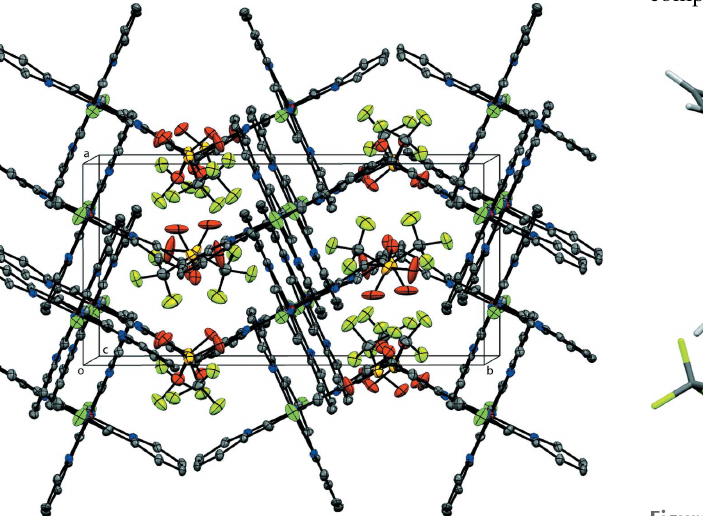
Figure 3 Capped stick representation of the title molecule showing the (cid:2) – (cid:2) stacking interactions (red).